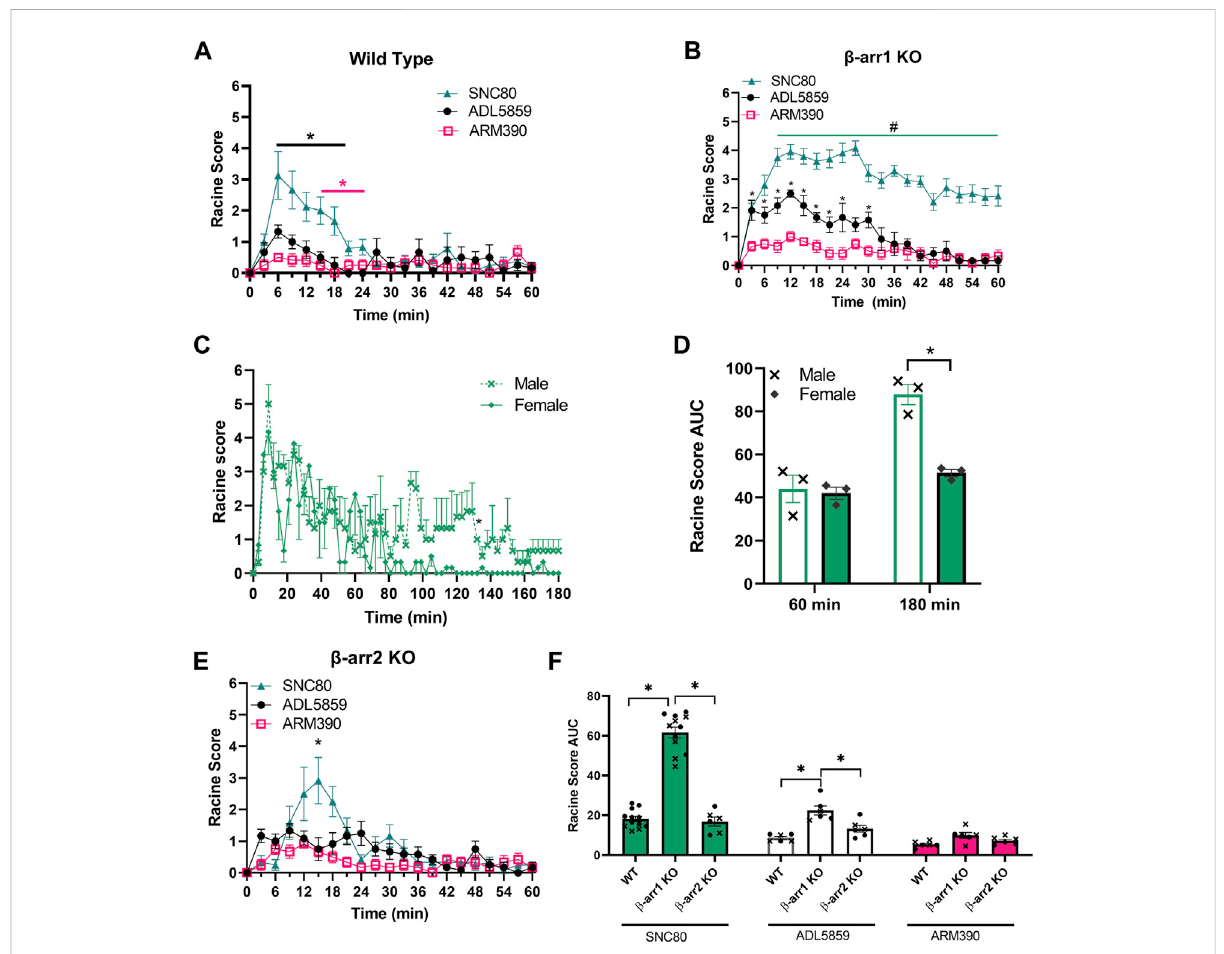
FIGURE 2 β -arrestin 1 knockout mice display enhanced seizure activity for δ OR agonists relative to wild-type and β -arrestin 2 knockout mice. (A) Seizure activityover1hperiodfor equi-antinociceptive dosesofSNC80(10mg/kgi.p.),ADL58589(30mg/kg,i.p.)andARM390(10mg/kgp.o.)inwild-type mice. (B) Seizure activity in β -arrestin 1 KO mice. (C) Seizure activity for SNC80 in male and female β -arrestin 1 KO mice over a 3-h period. (D) Area under the curve (AUC) for seizure activity induced by SNC80 (10 mg/kg i.p.) in male and female mice in β -arrestin 1 KO mice over 60 and 180 min. (E) seizure activity in β -arrestin 2 KO mice (F) Area under the curve for SNC80, ADL 58589 and ARM 390 in wild-type, β -arrestin1 KO, and β - arrestin 2KOmice. Racinescoredataisshown60minutespost-injection.Equalnumberofmales andfemalesweretested